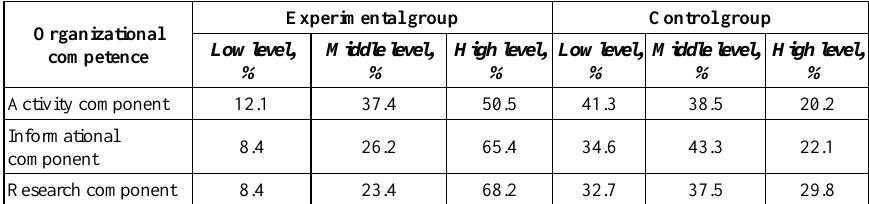
Table 2. Level of professional competence of future green engineers in the experimental and control groups at the end of the